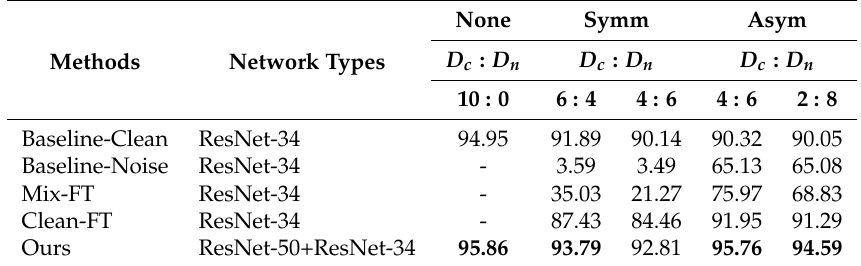
Table 6. Classification accuracy (%) on the NWPU-RESISC45 test set for different